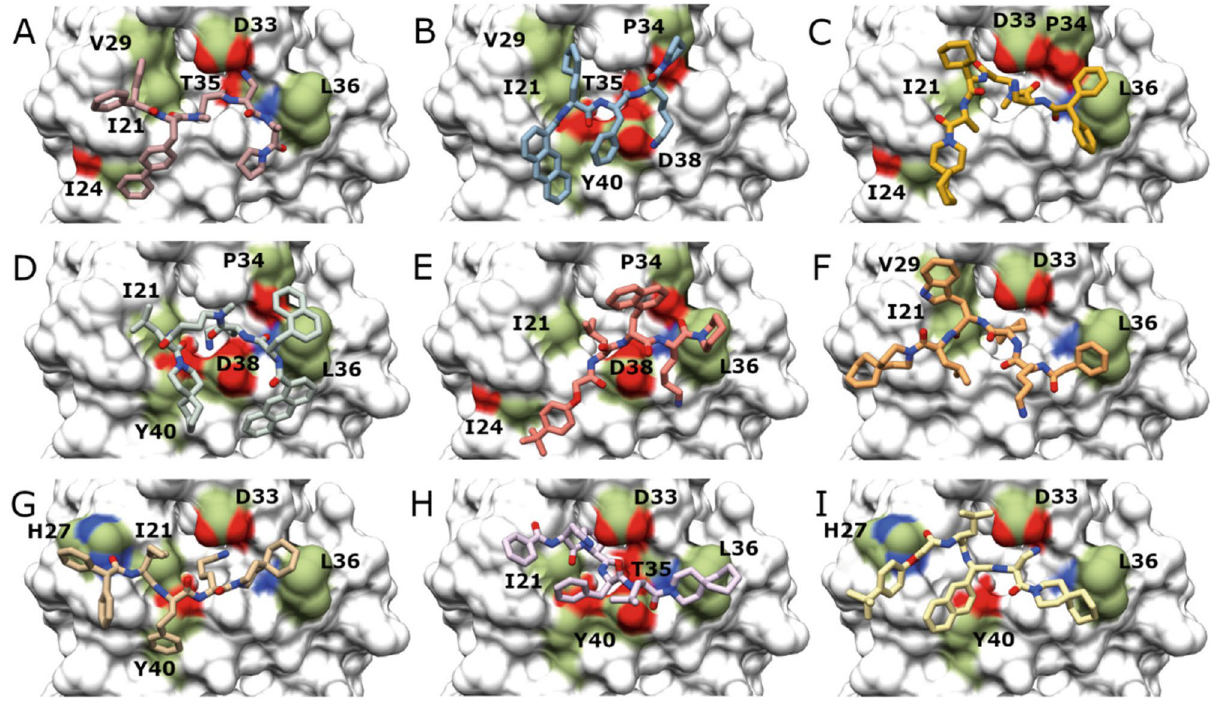
Figure 2. Peptidomimetic characteristics. In silico predicted binding modes of ( A ) P1, ( B ) P2, ( C ) P3, ( D ) P4, ( E ) P5, ( F ) P6, ( G ) P7, ( H ) P8 and ( I ) P9. Contact point residues on the RAS surface (PDB code 5P21) are shown in colour on the RAS protein surface: aliphatic areas are shown in green, areas with amino groups in blue and areas containing carboxylic moieties in red. RAS residues involved in contact with the compounds are named using the one letter amino acid code; the residue number is shown next to the letter. Images were drawn using the docking program indicated in